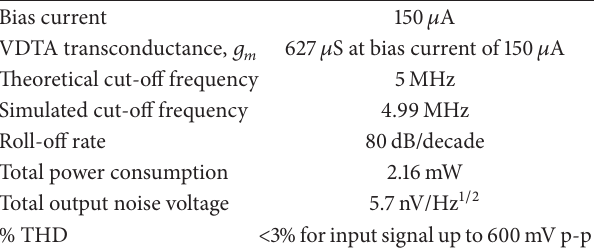
Figure 16: Bread-boarded circuit of Figure 7. Table 3: Key parameters of simulated 4th-order low pass ladder